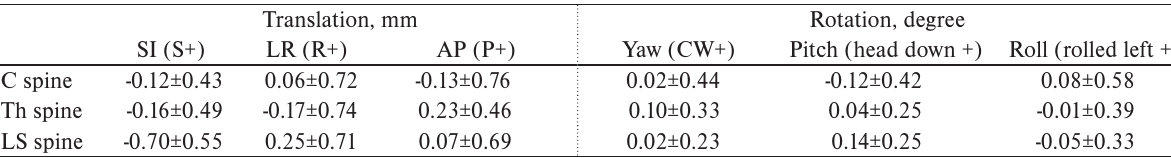
Table 1. The translation and rotation of the cervical (C), thoracic (Th) and lumbar-sacral (LS) regions of the spine during SBRT treatment.